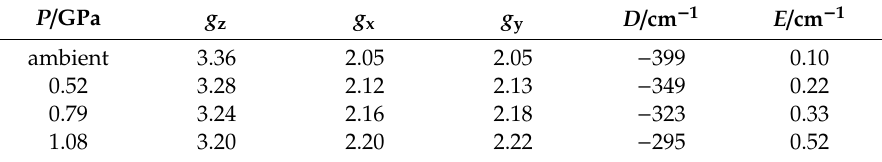
Table 10. Parameters used for the simulation of the magnetic data for complex 13 . P / GPa g z g x g y